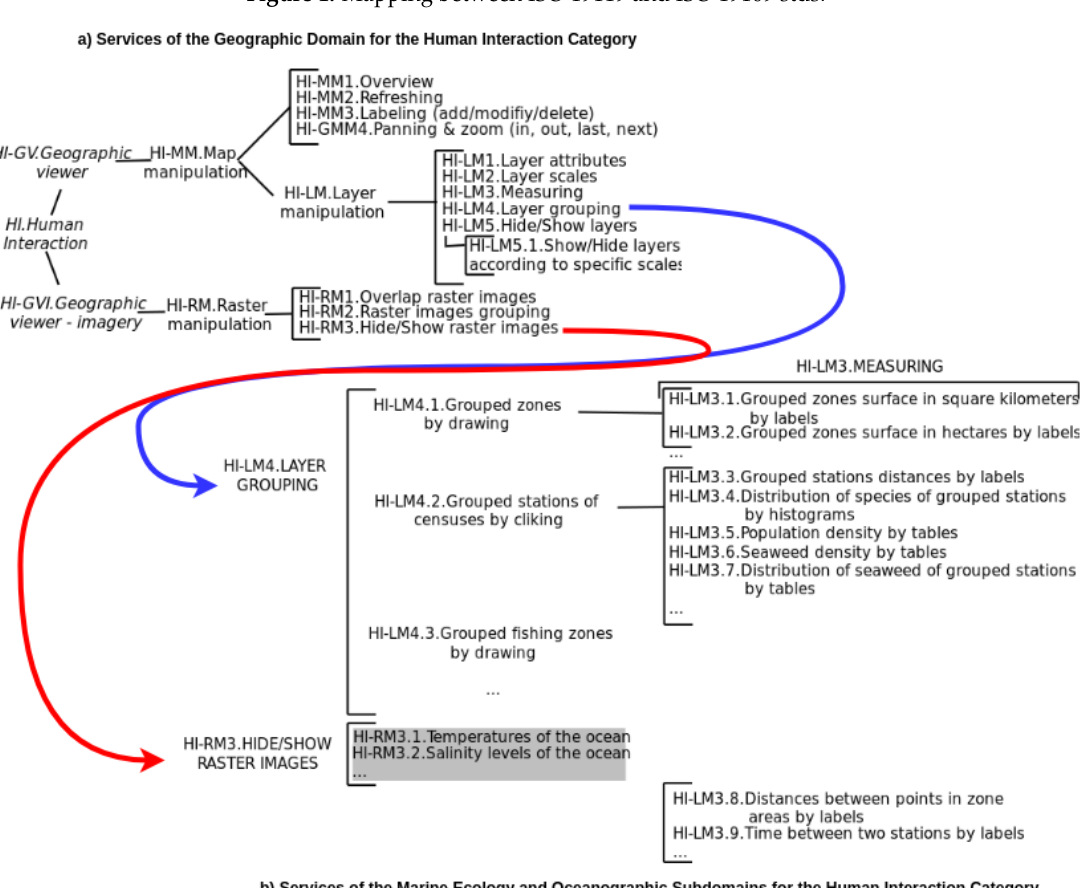
Figure 2. ( a ) Service taxonomy for the geography domain, and ( b ) marine ecology and oceanography subdomains for the human interaction